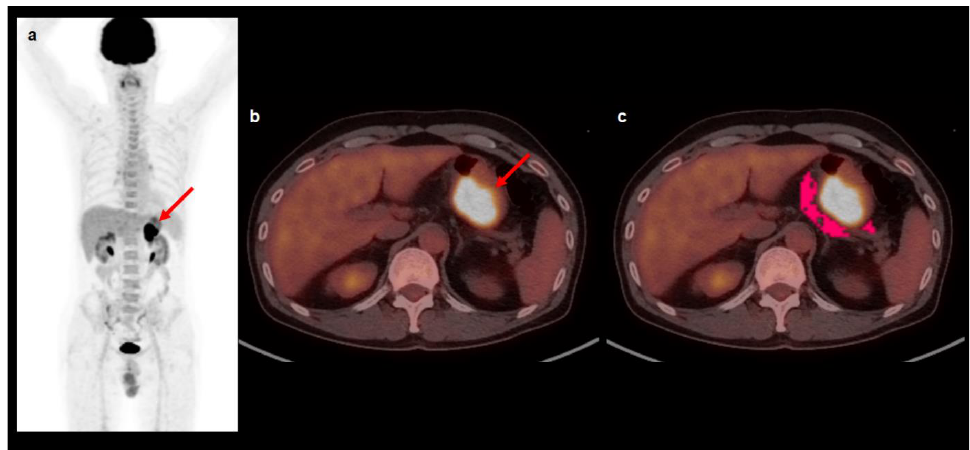
Figure 2. Maximal intensity projection image ( a ) and transaxial images ( b , c ) of [ 18 F]FDG PET/CT illustrating VOI for measuring textural features of perigastric AT. A 59-year-old man underwent [ 18 F]FDG PET/CT for staging work-up of gastric cancer in the stomach body. The gastric cancer le- sion showed intensely increased [ 18 F]FDG with the maximum SUV of 17.99 (arrows on ( a , b )). A VOI that covers the area within a 1 cm distance to the margin of primary gastric cancer was manually drawn, and perigastric AT was defined as an area of CT-attenuation range between − 190 HU and − 30 HU within the VOI (red area in ( c ). The mean SUV, GLCM homogeneity, GLCM entropy, and GLCM dissimilarity of the perigastric AT were 1.05, 0.74, 3.01, and 0.49, respectively. The patient